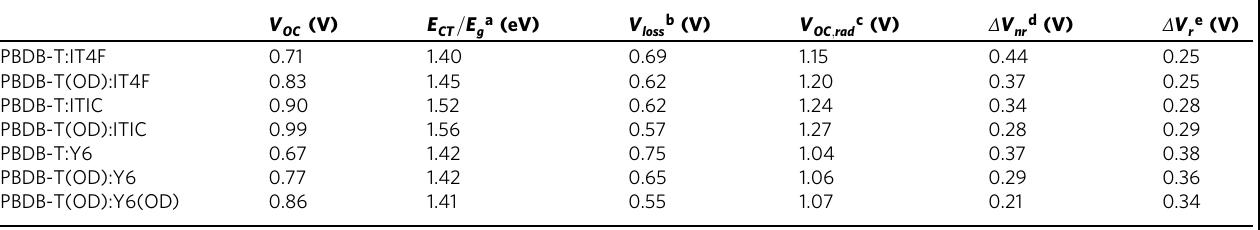
Table 2 Voltage loss values from the subgap EQE measurements for the BHJ solar cells based on PBDB-T and PBDB-T(OD) mixed with different acceptors. V OC (V)